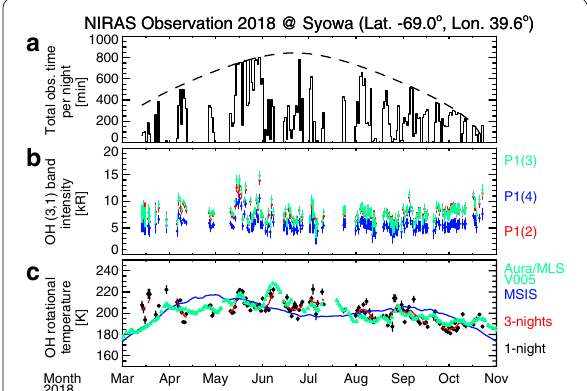
Fig. 3 NIRAS spectral measurements of OH Meinel (3,1) band at Syowa station in 2018 austral winter. Results obtained by measurements with the 600-lpmm grating are only shown. a Total exposure time for nightly mean intensities and temperature on each night. We only used good SNR data for the mean and a detail is described in a main text. A dashed curve indicates amount of time when SZA is greater than 100 ° on each night. Note that the time is multiplied by a factor of 5/6 because a cycle of measurement has one dark frame and five sky frames. b Nightly mean of P 1 (2), P 1 (3), and P 1 (4) line intensities in OH (3,1) band. c Nightly mean of OH rotational temperatures estimated by a ratio between P 1 (2), and P 1 (4) line intensities. The nightly mean and 3-days smoothing are indicated by black diamonds and red lines, respectively. A blue curve is seasonal variations of 3-day smoothed temperature at 87-km altitude calculated by NRLMSISE-00 (Picone et al. 2002). Green triangles are 3-day smoothed temperature at geopotential height of 80 km obtained from